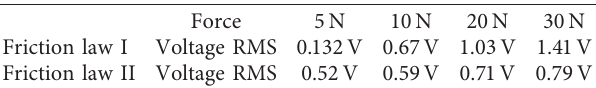
Figure 4: Vibration displacement (a), velocity (b), and output voltage (c) of the friction system with different normal loads in the friction law II. Table 1: The RMS of output voltage of the friction system with the variation of normal